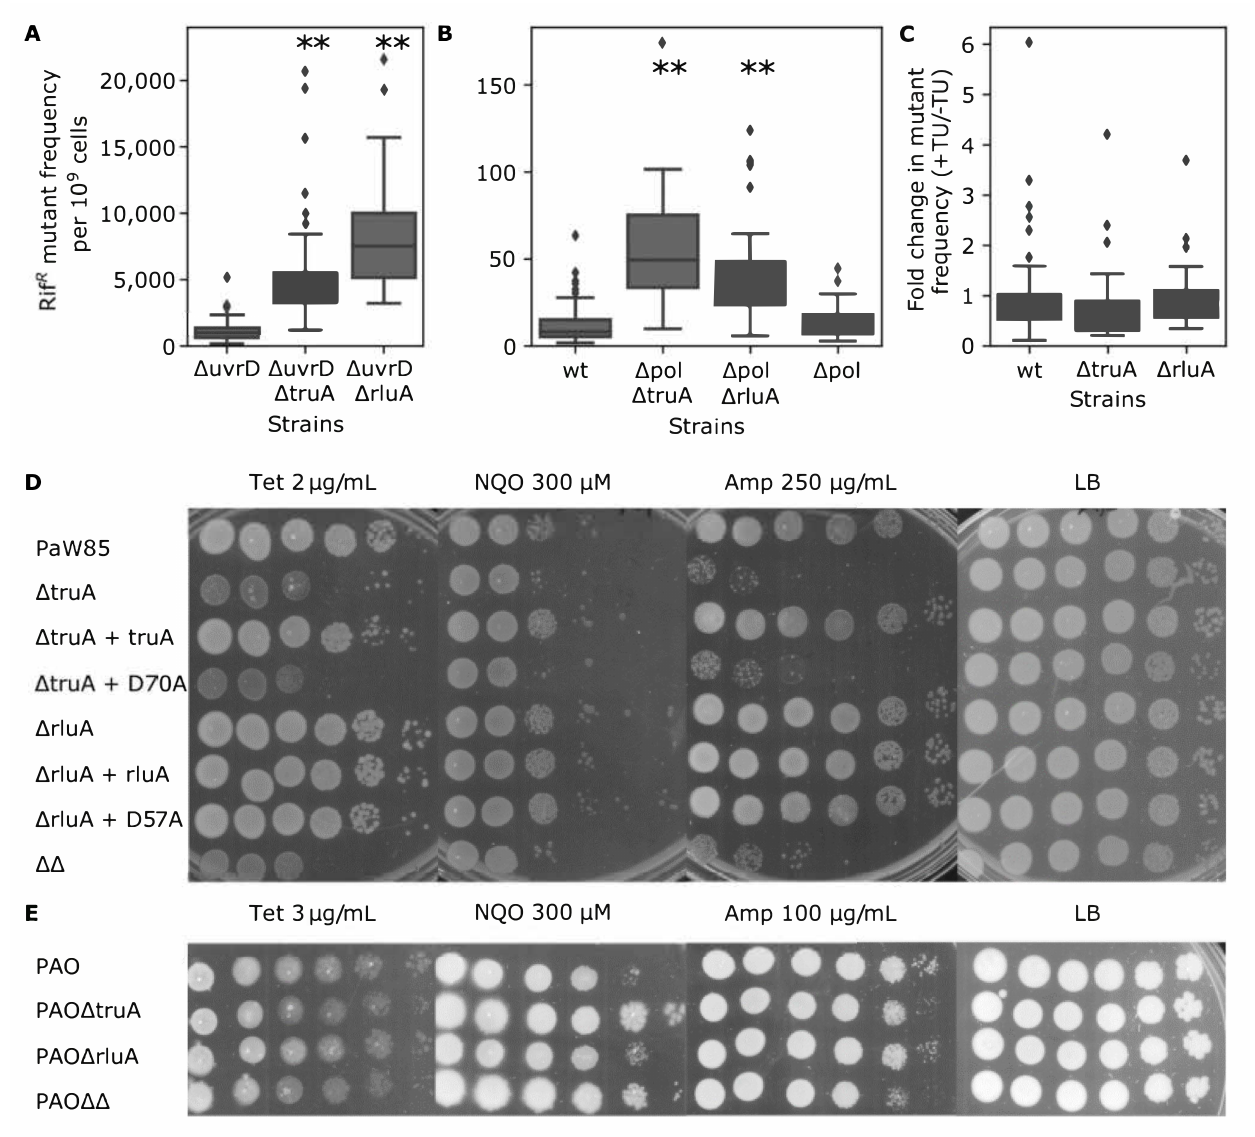
Figure 3. Comparison of Rif R mutant frequencies in TruA and RluA proficient and deficient strains lacking additionally DNA repair or TLS polymerases functions, and estimation of phenotypic effects of the absence of TruA and RluA on stress tolerance. The mean values (line in the box) of Rif R mutant frequencies per 10 9 live cells are presented. The upper and lower borders of box represent third and first quartile, respectively, the whiskers represent non-outlier range and diamonds correspond to outliers. In each strain n ≥ 30. ( A ) uvrD and truA or rluA double mutant compared to the uvrD mutant strain, “**” indicate p -value <0.001 compared to ∆ uvrD. ( B ) P. putida PaW85 (wt) compared to TLS DNA polymerases mutant ( ∆ pol) and ∆ pol lacking truA or rluA . ∆ pol— P. putida strain lacking imuAB , imuC , polB, and dinB genes, “**” indicate p -value <0.001 compared to the wild-type strain. ( C ) Mutant frequency change of the wild-type P. putida PaW85 (wt), truA deletion strain ( ∆ truA) and rluA deletion strain ( ∆ rluA) with (+) and without ( − ) thiourea (TU). The ratio of Rif R mutant frequency with TU and without TU is shown. The mean values (line in the box) of ratio are presented. The upper and lower borders of the box represent third and first quartile, respectively, the whiskers represent non-outlier range and dimonds indicate outliers. In each strain n = 30. Panels ( D , E ) show plate assay of the stress tolerance of the P. putida PaW85 wild-type strain and the truA and rluA deficient strains and the P. aeruginosa PAO1-L wild-type strain and the truA and rluA deficient strains, respectively. Tenfold dilutions of overnight culture were spotted onto LB agar plates containing indicated chemical and incubated at 30 ◦ C for 24 h (Tet, 48 h) for P. putida and 48 h for P. aeruginosa . ∆ truA + truA/ ∆ rluA + rluA—deletion strain complemented with functional gene; ∆ truA + truAD70A/ ∆ rluA + rluAD57A—deletion strain complemented with catalytically inactive TruA or RluA, respectively; ∆∆ —strain lacking both truA and rluA